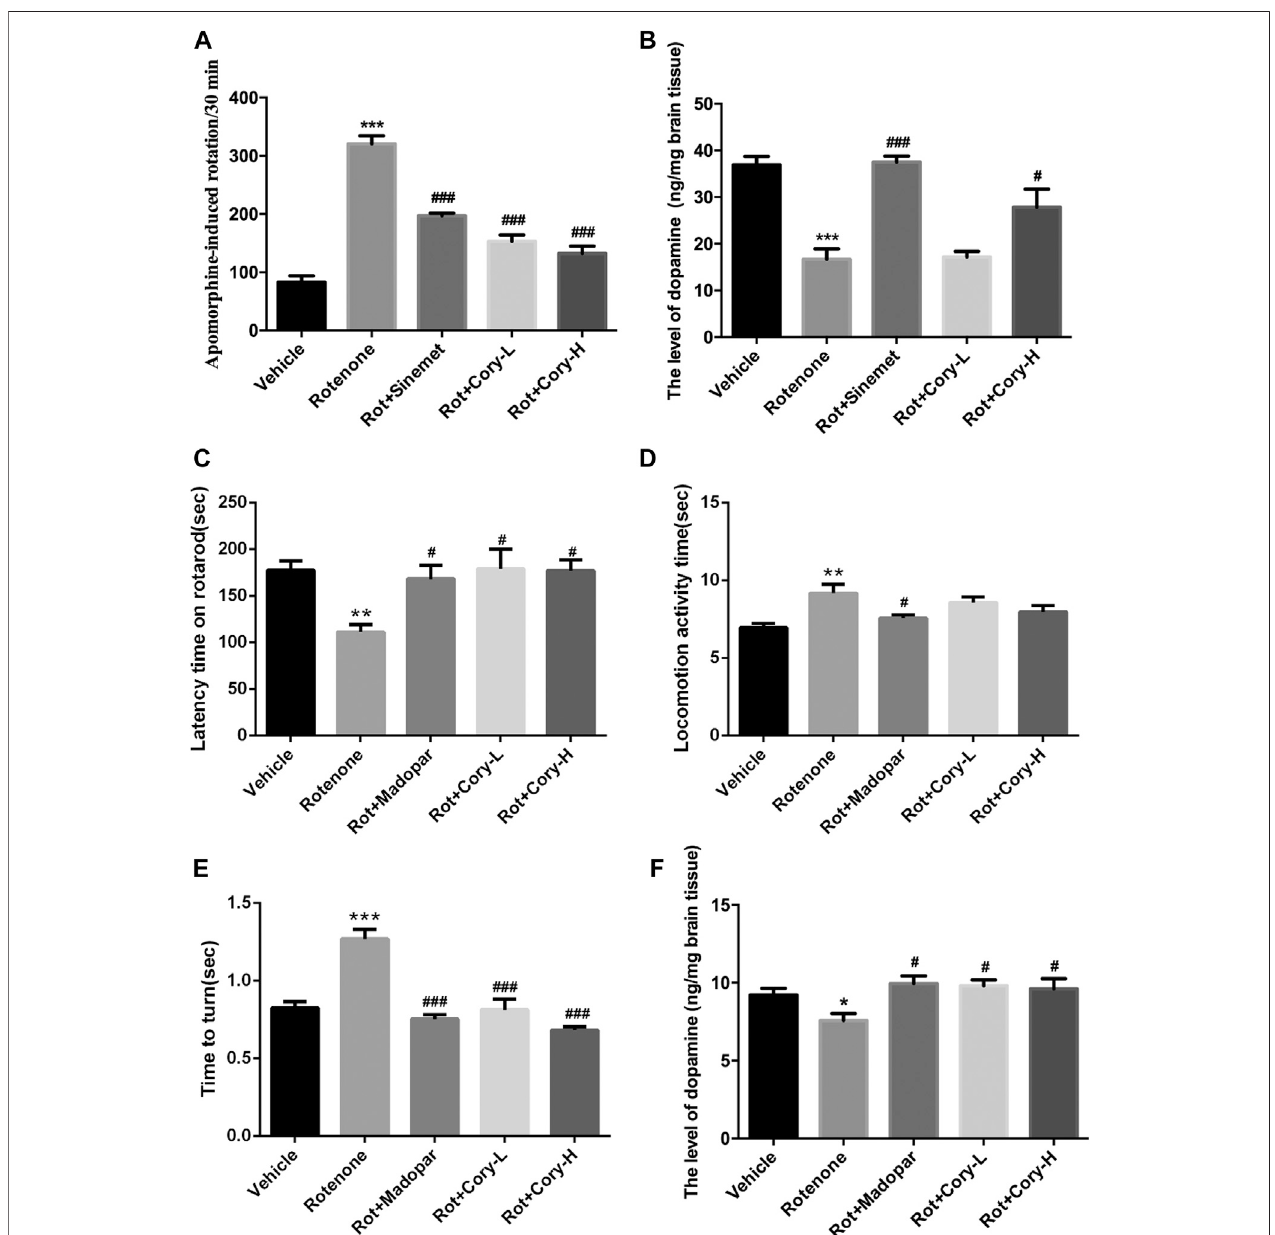
FIGURE 1 | Cory improves the motor dysfunction and increases the striatal dopamine level in the rotenone-induced rat and mice models. (A – B) Tests in the rotenone-induced ratmodelofPD,and (C – F) testsintherotenone-inducedmicemodelofPD. (A) Rotation testinducedbyapomorphine (2.5 mg/kg)wasperformedat theendofthefourthweekafterrotenoneratmodelestablishment.Rotationsof30 minweretotaled.CoryincreasesthelevelofdopamineinthestriatuminbothofthePD rat (B) and mice (F) models. In the rotarod test, Cory increases the movement time of rotenone-induced PD mice maintained on the rotarod (C) . In the pole test, although the effect of Cory to shorten the locomotion activity time is not signi fi cant (D) , Cory signi fi cantly shortens the turning time (E) . Dosage of Cory in the rotenone- induced rat model of PD: Cory-L: 2.5 mg/kg, Cory-H: 5 mg/kg. Dosage of Cory in the rotenone-induced mice model of PD: Cory-L: 5 mg/kg, Cory-H: 10 mg/kg. Data werepresented asmean ± SEM.(* p < 0.05,*** p ＜ 0.001comparedwiththeShamorVehiclegroup, # p < 0.05, ### p < 0.001comparedwiththeRotenonegroup, n ≥ 6; one-way ANOVA with Newman – Keuls ’ multiple